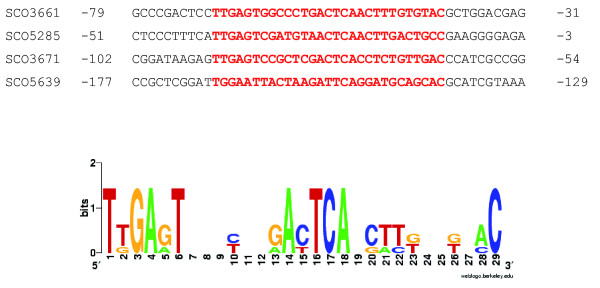
Consensus operator sequence for HspR. The nucleotide sequence was determined by the alignment of the upstream regions of HspR targets identified by Sco-Chip2-v1 (see Materials and methods). The sequences are displayed above the consensus plot; numbering of nucleotides is relative to the predicted start codon of each gene. In the graphical representation of the consensus sequence the height of each nucleotide indicates the level of conservation [76,77].